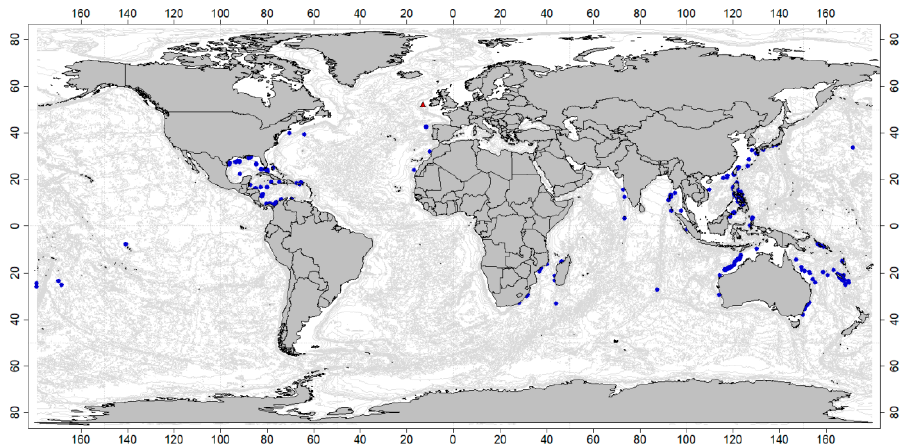
Figure 2. Distribution map of Neoscopelus microchir showing georeferenced location points of this species reported by GBIF and OBIS (blue dots). The red triangle mark represents the new location on the Porcupine Bank.